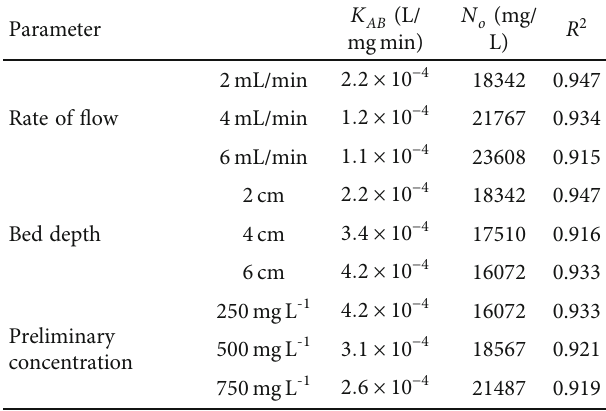
Table 2: Adams-Bohart model parameters for the removal of Pb 2+ ions at various conditions.